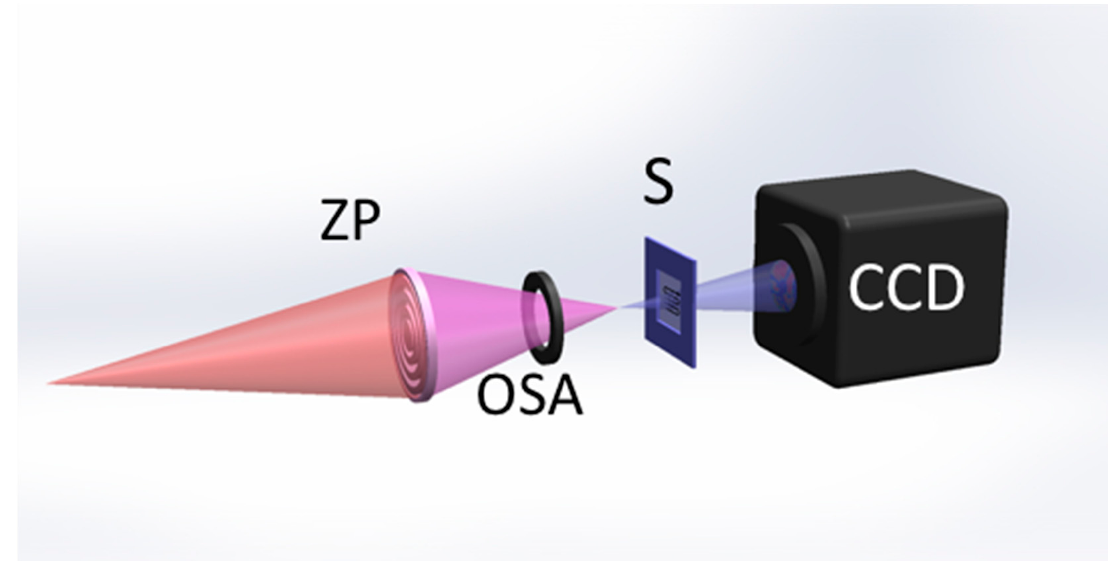
Figure 4. Schematic view of the TwinMic ptychography setup with the zone plate (ZP), the order-selecting aperture (OSA), the specimen (S), and the CCD camera.